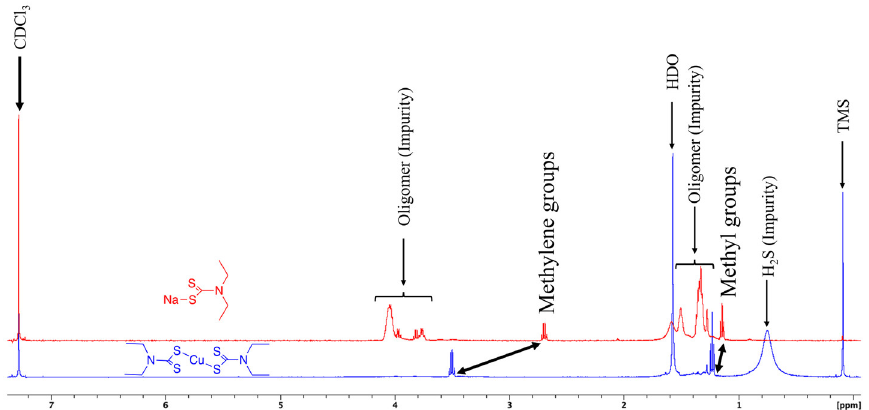
Figure 1. Comparison of 1 H-NMR of Na(DDTC) (red) and Cu(DDTC) 2 (blue).